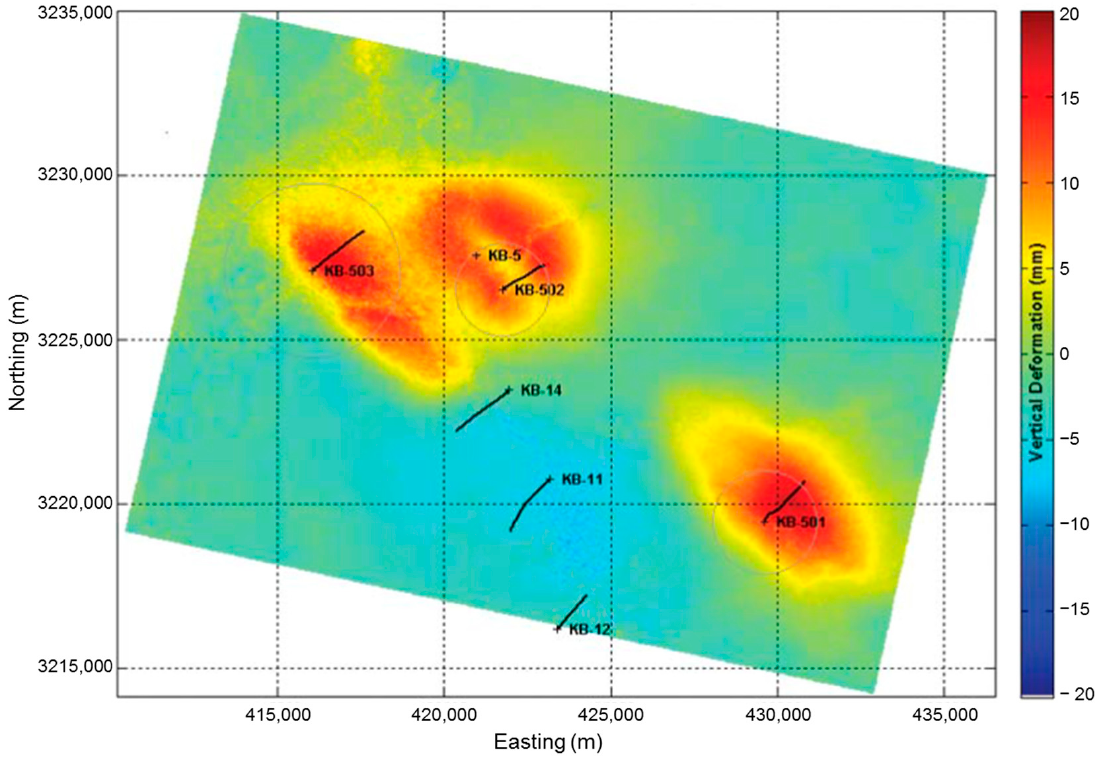
Figure 6. Surface deformation observed in CO 2 injection and production wells at the Krechba site (cited in Mathieson A et al., 2010 [38]).